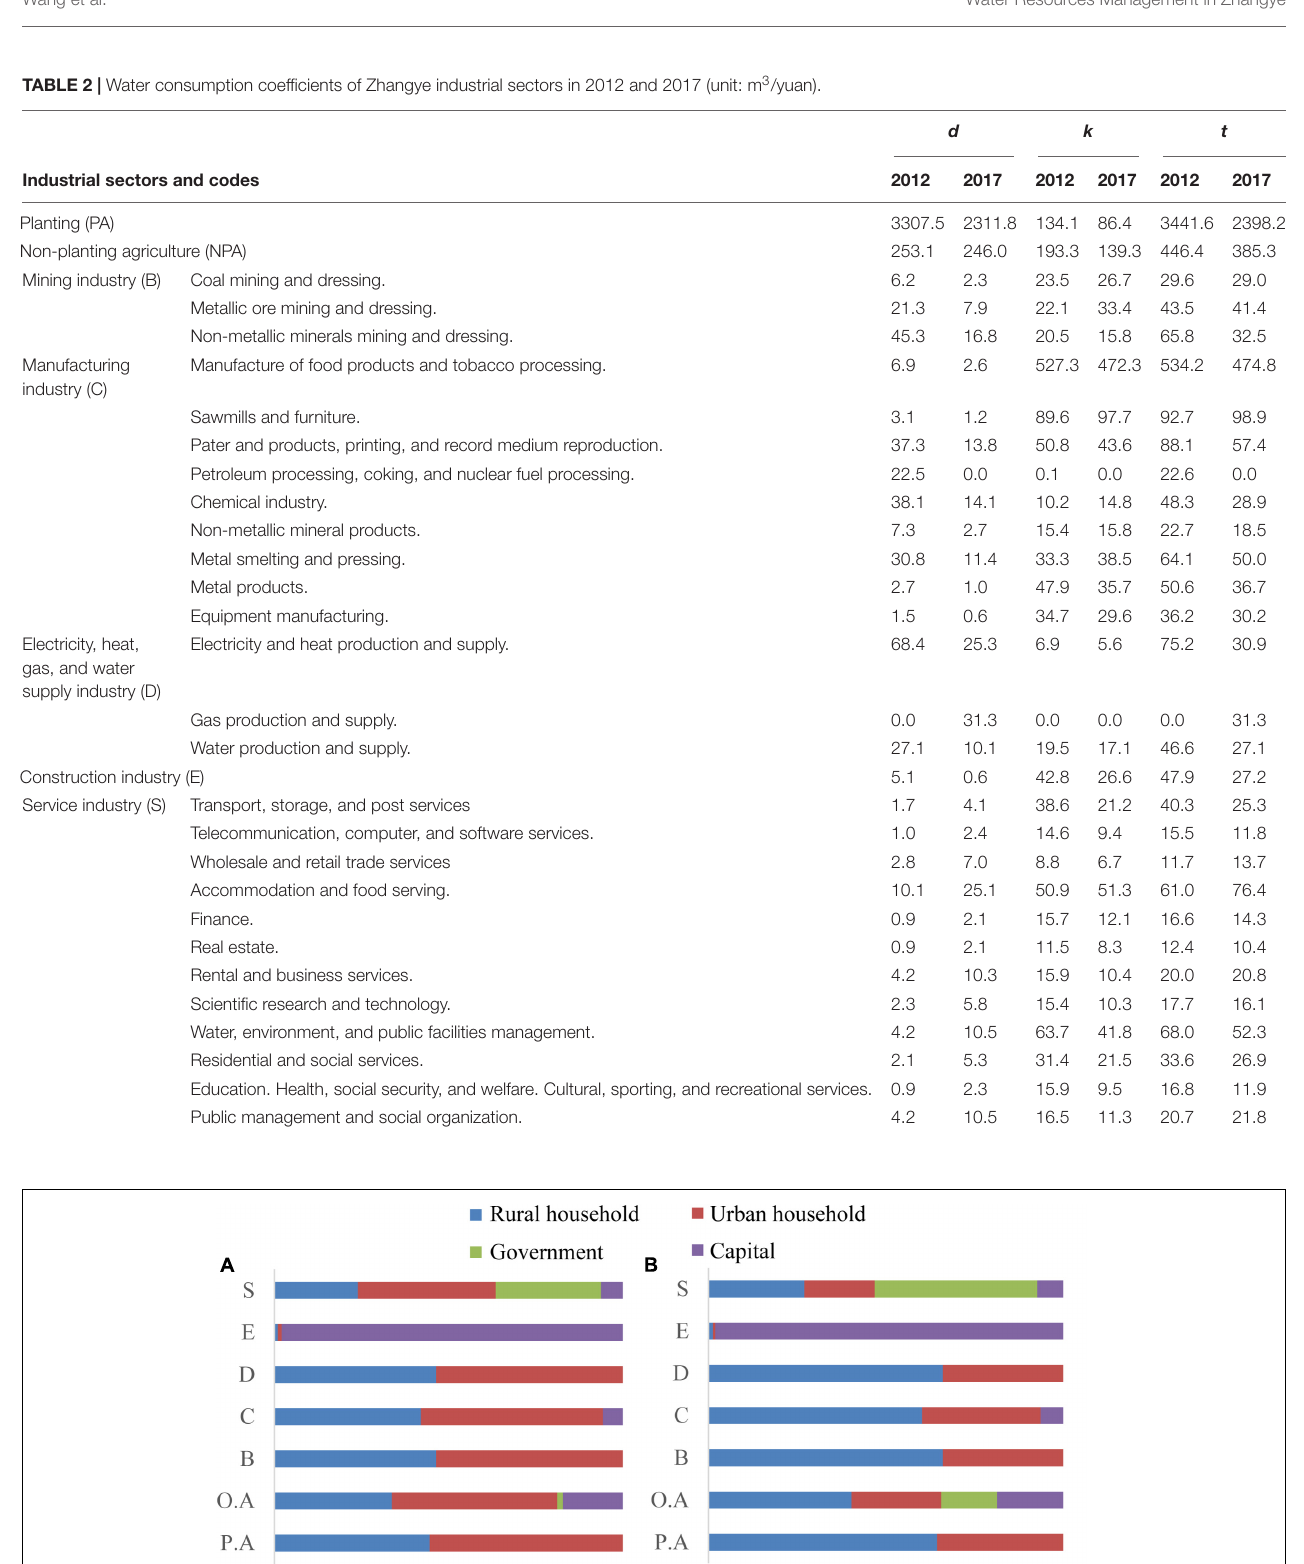
TABLE 2 | Water consumption coefficients of Zhangye industrial sectors in 2012 and 2017 (unit: m 3 /yuan).